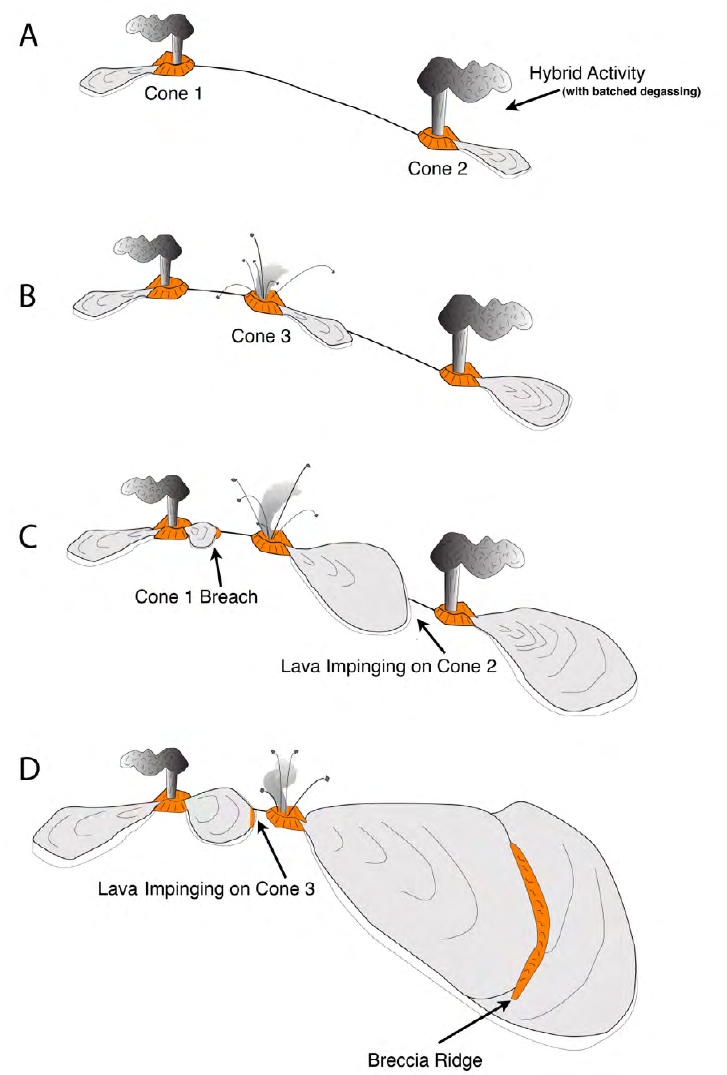
Figure 7: Schematic showing possible erup- tive events leading to the formation of jux- taposed explosive and effusive deposits at Big Glass Mountain. Multiple eruptive vents were aligned along a NNW trending fissure (bold diagonal line), as shown in this per- spective view from the southwest [see also Chesterman 1955; Eichelberger 1975]. [A] Initial pyroclastic eruptions occurred from northern and southernmost vents (Cones 1 and 2) along the main fissure [Eichelberger 1975]. [B]–[C] A third, middle vent (Cone